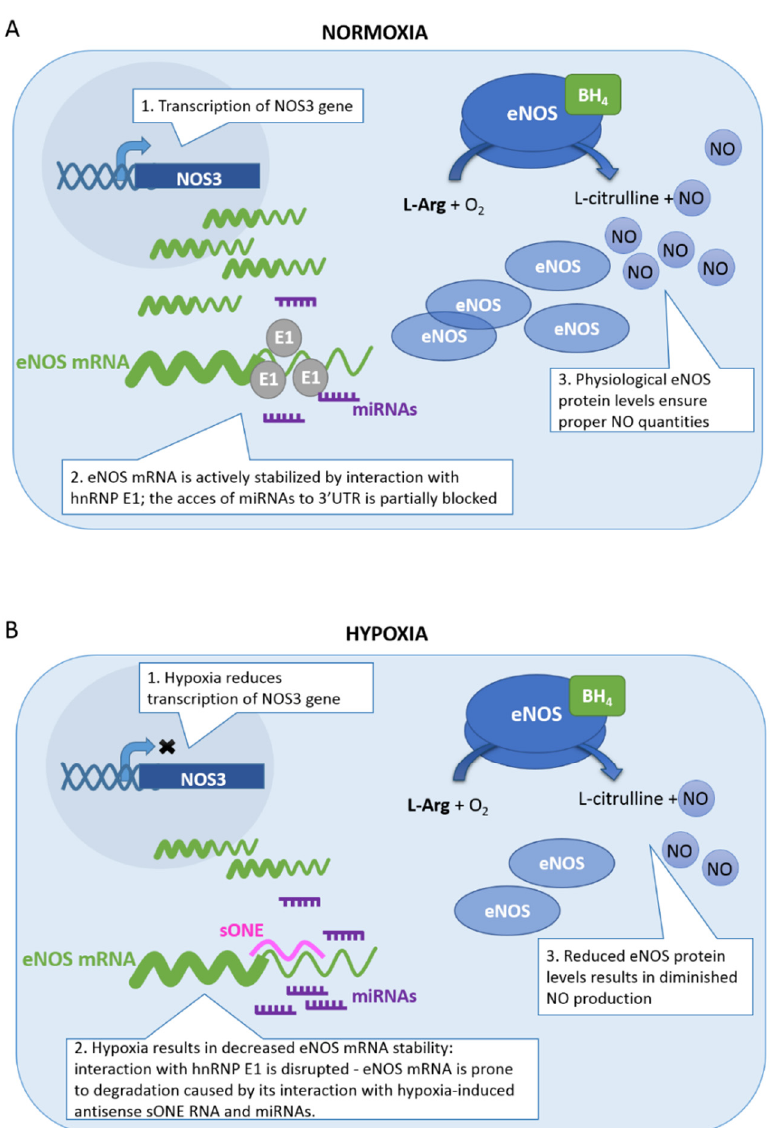
Figure 1. Regulation of eNOS expression in normoxia ( A ) and hypoxia ( B ). Hypoxic downregulation of eNOS is due to decreased transcription and reduced mRNA stability. In hypoxic ECs, eNOS mRNA is not stabilized by hnRNP E1, and its 3 ′ -UTR interacts with hypoxia-induced antisense sONE transcript, as well as with miRNAs, resulting in increased eNOS mRNA degradation.